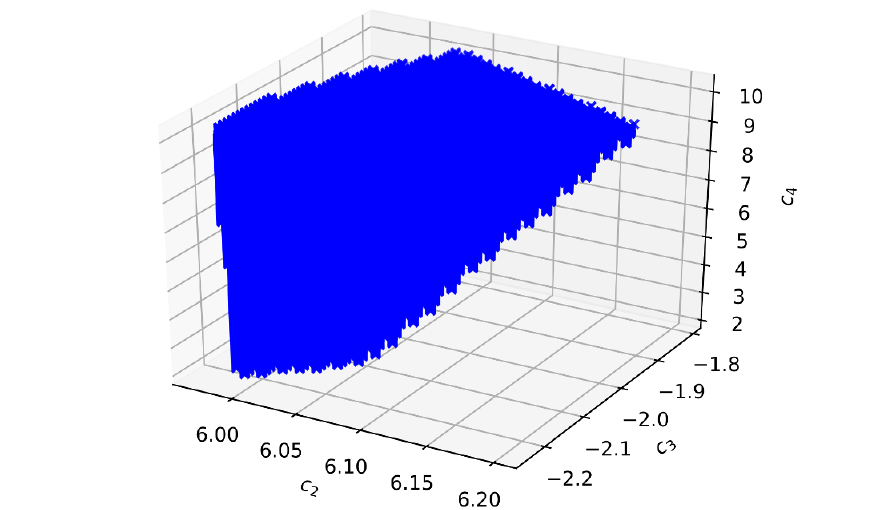
Figure 2. Numerical scan over (cid:0) 10 (cid:20) c i (cid:20) 10 for i = 2 ; 3 ; 4, taking c 1 = (cid:0) 10 : 0 and with step size (cid:1) c = 0 : 01. Points which satisfy all inequalities given in the \summary of constraints" are labelled by a blue (cid:2)